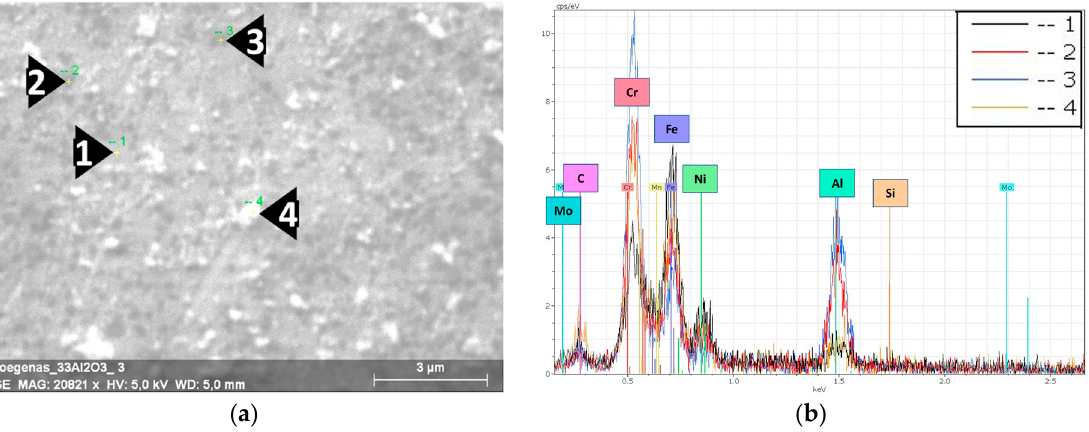
Figure 3. EDS results of the milled 316L/0.33 wt% Al 2 O 3 . ( a ) SEM image of a 316L grain’s surface; ( b ) EDS spectra of the selected spots.